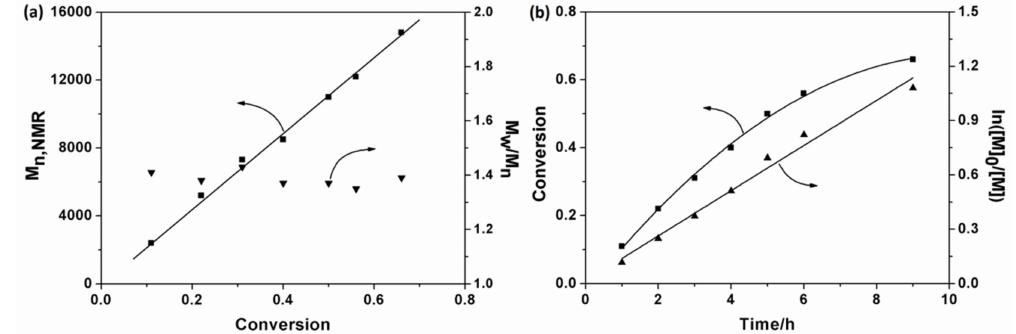
Figure 1. Kinetics of the copolymerization of CTFE and BVE: ( a ) molar mass and dispersity as functions of monomer conversion; ( b ) monomer conversion and ln([M] 0 / [M]) as a function of polymerization